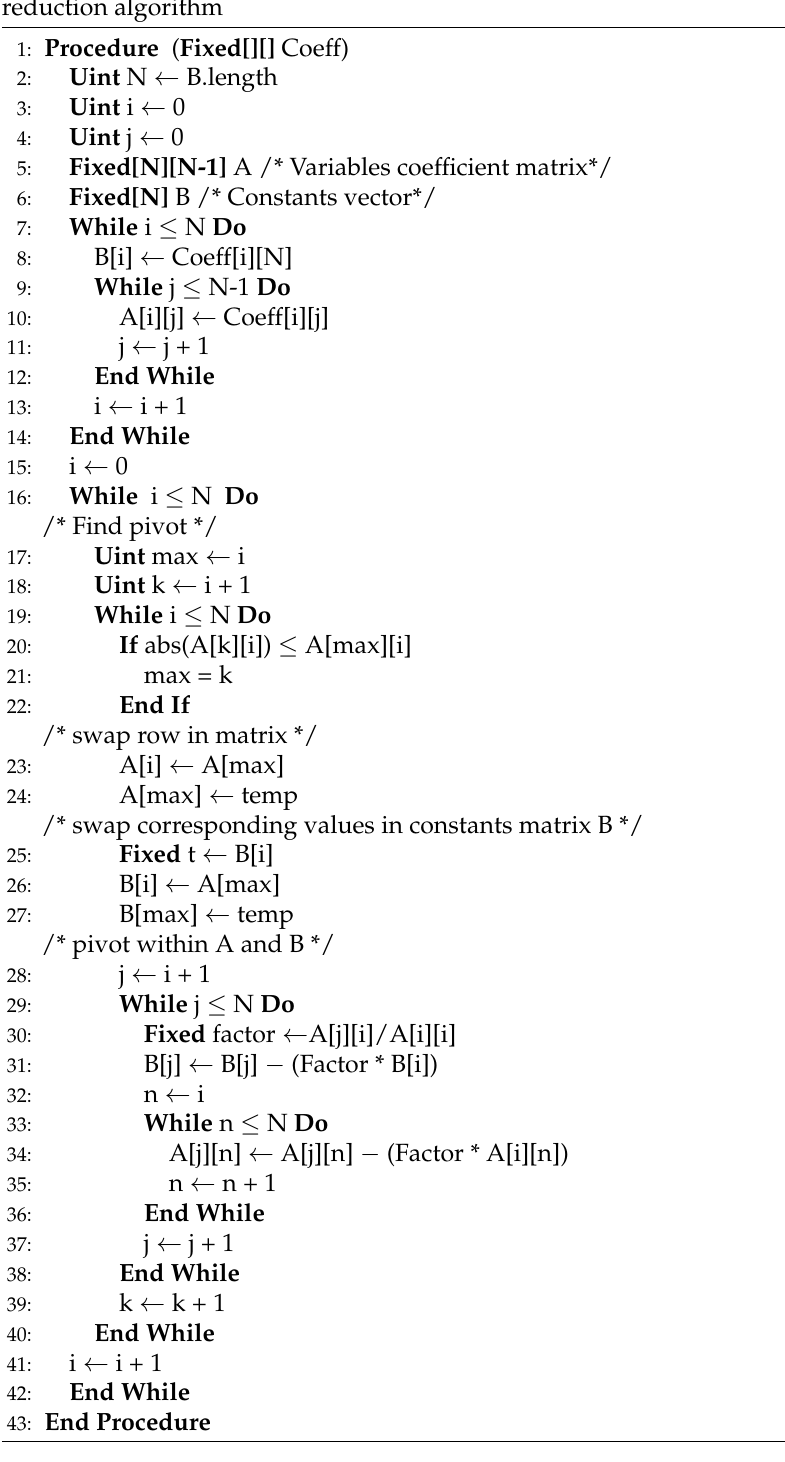
Algorithm 4 OPF Solver Smart contract: Solve a system of linear equations using row- reduction